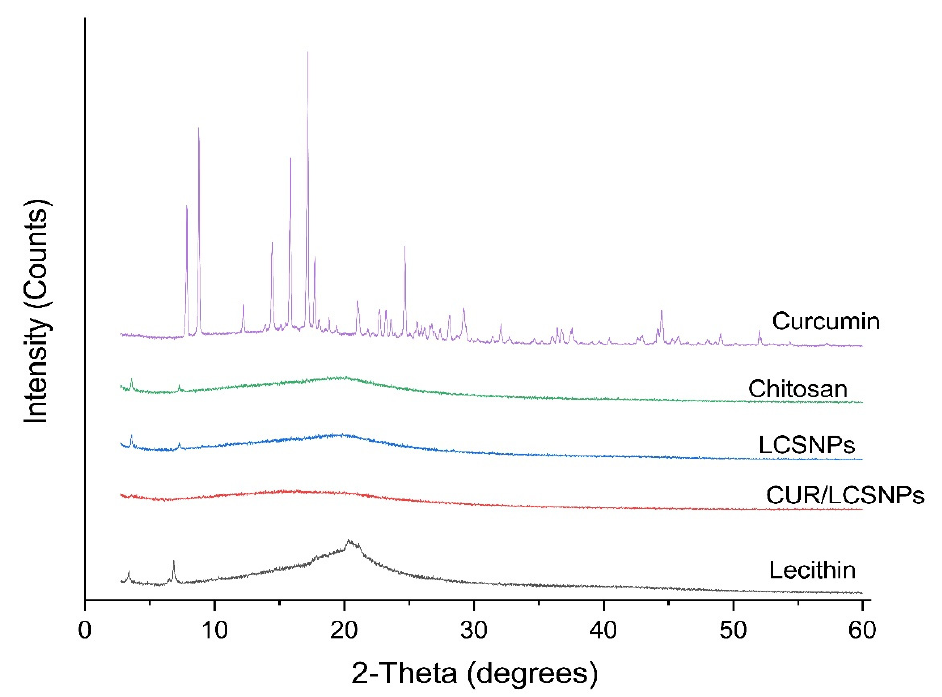
Figure 5. X-ray diffractograms of pure curcumin, lecithin, chitosan, LCSNPs, and